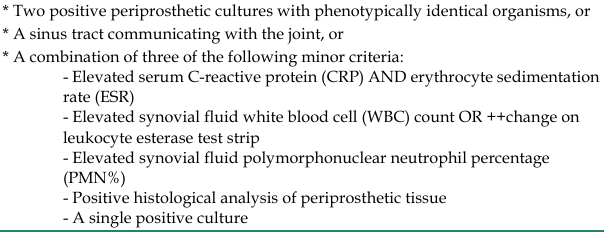
Table 1. Criteria for deep PJI